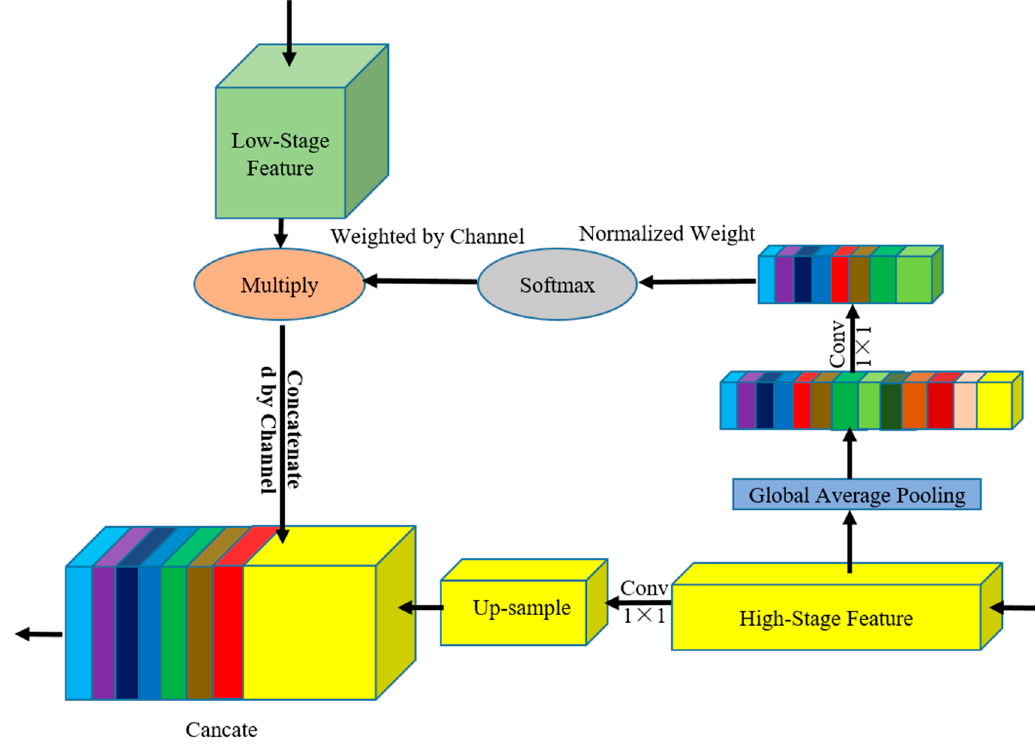
Figure 4. GAM architecture. Light green squares represent the characteristics of the low-stage maps, and yellow squares represent the high-stage maps. We connected the features of the adjacent stages to calculate the weight vector and then reweighted the low-stage feature map.